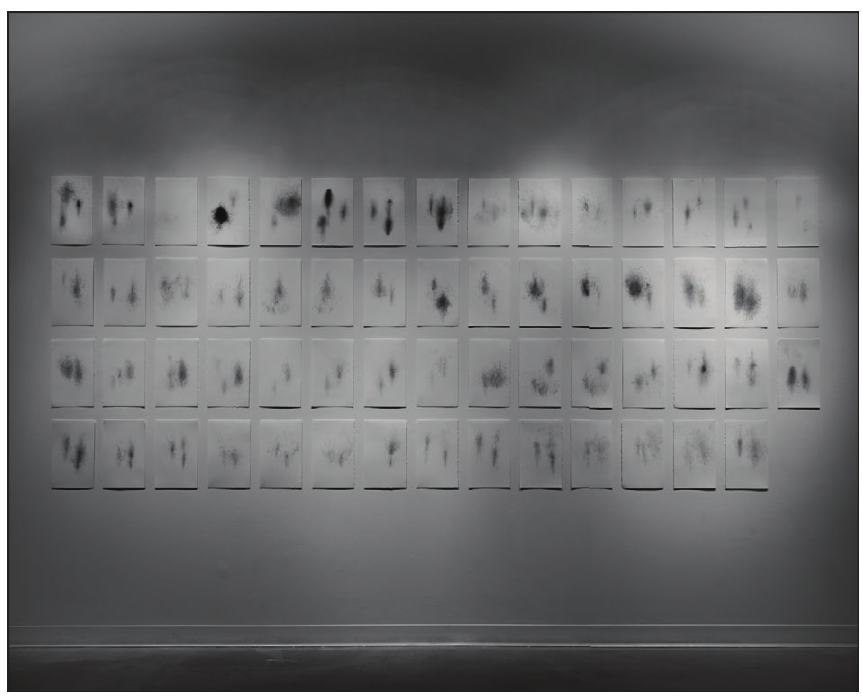
Figure 16: Sarah Irvin, Rocking Chair Drawings, Graphite on paper, 56 × 132 inches,